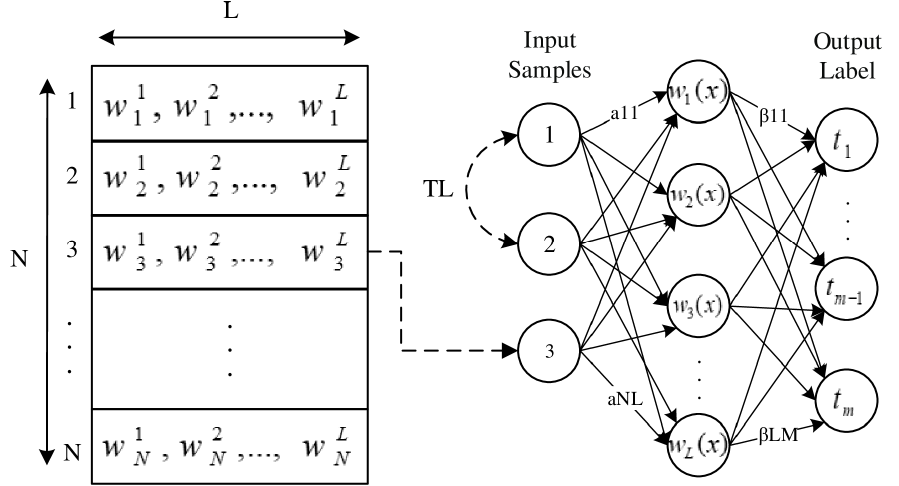
Figure 3. ITM ‐ OSELM network and its two sources of updates: external memory EM and transfer Figure 3. ITM-OSELM network and its two sources of updates: external memory EM and transfer learning TL. learning